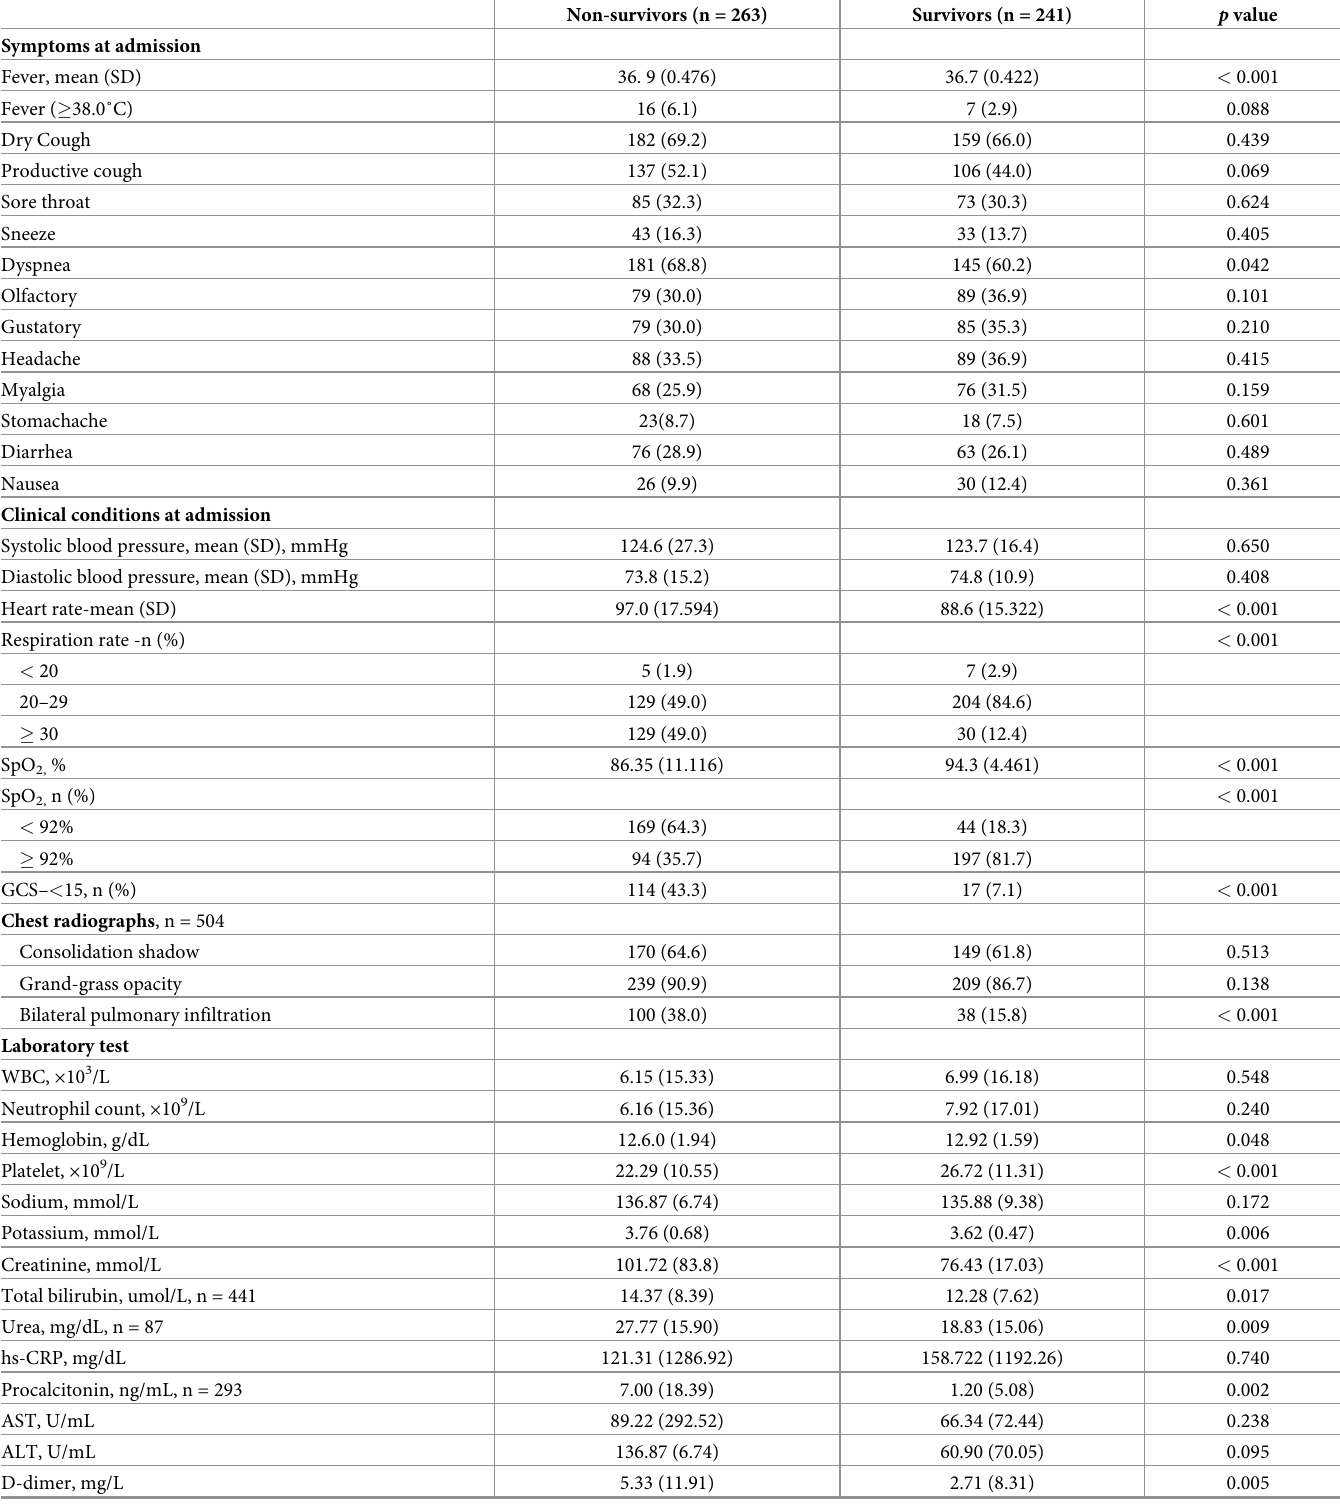
Table 2. Clinical presentation and laboratory test results at the time of hospital admission among patients with